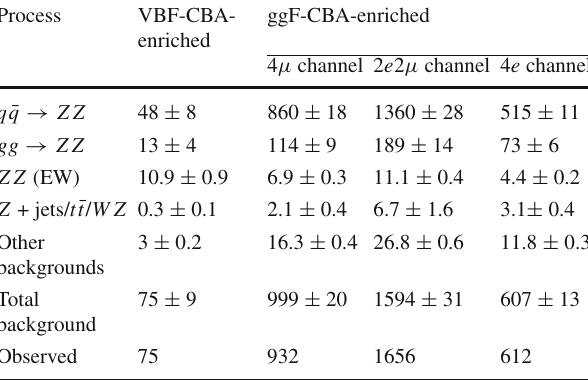
Table 5 (cid:3) + (cid:3) − (cid:3) (cid:2)+ (cid:3) (cid:2)− search: expected and observed numbers of events for m 4 (cid:3) > 200 GeV, together with their uncertainties, for the VBF- CBA-enriched and ggF-CBA-enriched categories using the cut-based categorisation. The expected numbers of events, as well as their uncer- tainties, are obtained from a combined likelihood fit to the data under the background-only hypothesis. The uncertainties of the Z Z normali- sation factors, presented in Table 6, are also taken into account Process